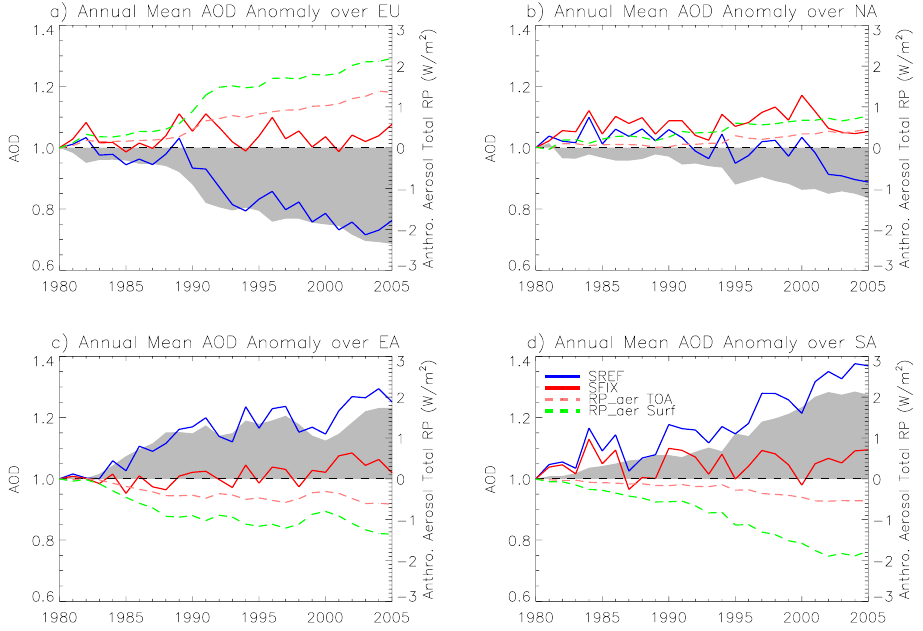
Fig. 15. Annual anomalies of total aerosol optical depth (AOD) averaged over the selected regions (shown in Fig. 1). On the left y-axis anomalies of AOD for the period 1980–2005 are expressed as the ratios between annual means for each year and 1980. The blue line represents the SREF simulation (changing meteorology and changing anthropogenic emissions), the red line the SFIX simulation (changing meteorology and fixed anthropogenic emissions at the level of 1980), while the gray area indicates the SREF-SFIX difference. On the right y-axis the pink and green dashed lines represent the clear-sky aerosol anthropogenic radiative perturbation at the top of the atmosphere (RP TOA aer ) and at the surface (RP Surf aer ),